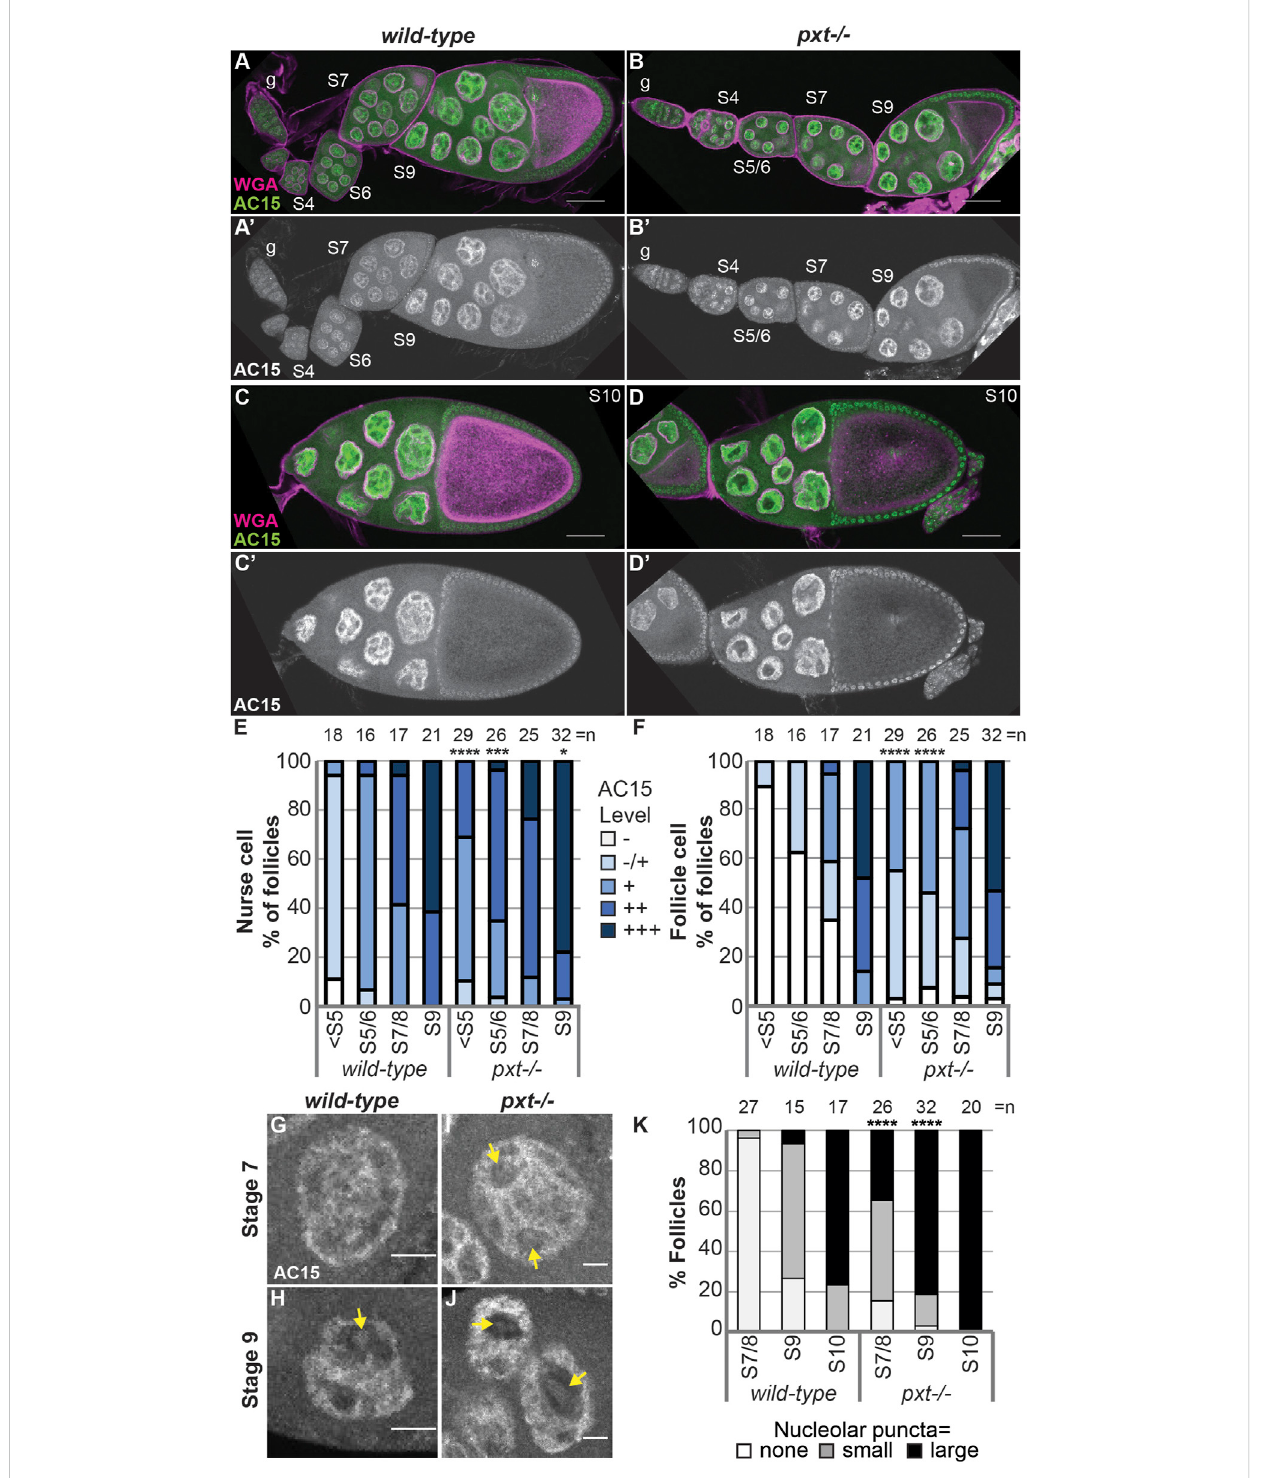
FIGURE 5 Prostaglandins restrict the developmental pattern and level of AC15 nuclear actin. (A-D ’ ) . Maximum projections of two confocal slices of wild-type and pxt f mutant follicles of the indicated stages (S, germarium = g) stained for: nuclear envelope (WGA) in magenta in merge and AC15 in green in merge and white in single channel; scale bars = 50 μ m. (E,F) . Graphs quantifying the percentage of follicles at the indicated stages with different levels of AC15 ( − , − /+,+,++,+++,whitetodarkblue)stainingfornursecells (E) andfolliclecells (F) ,**** p < 0.0001,*** p < 0.001,** p < 0.01(Fisher ’ sexacttest).n= number of follicles. (G – J) . Maximum projections of two confocal slices of wild-type and pxt f mutant nurse cells of the indicated stages stained for anti- actin AC15 (AC15) from the same images in (A 9 ,B ’ ) . Yellow arrows indicate puncta. Scale bars = 10 μ m. (K) . Quanti fi cation of the percentage of follicles of the indicated stages exhibiting no (white), small (gray) or large (black) nucleolar puncta, **** p < 0.0001 (Pearson ’ s Chi-squared test). n = number of follicles.In (E,F,K) ,datafromboth pxt alleleswerecombined.LossofPxtresultsinearlierandstrongernuclearAC15staininginboththenurseandfollicle cells (A – F) , and earlier, larger, and more nucleolar AC15 puncta (G – K)